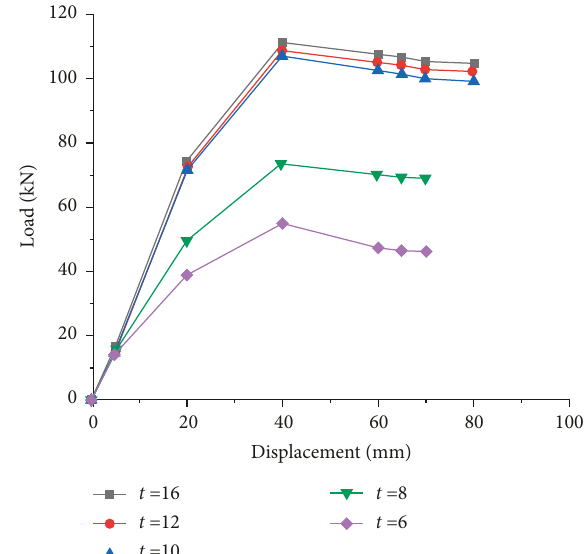
Figure 18: Load-displacement curves of joints with different sleeve